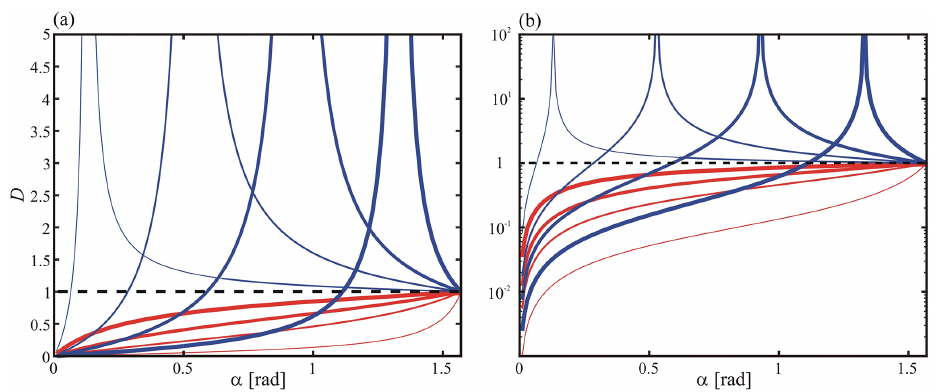
/λ Z , as a function of α , leaving a parametric dependence with ψ (see text). Arbitrary Figure 2. (a) Examples of the distortion in D = λ ap Z constant and progressive ψ values within the interval [ 0 ,π ] rad are shown. Underestimation of λ Z occurs when (D < 1 )ψ = 0 . 1, 0.5, 0.9, 1.3rad (curves with increasing thickness, from thin red to thickest red). Overestimation of λ Z occurs when D > 1 and ψ = 1 . 7, 2.1, 2.5 and 2.9rad (thin blue to thickest blue curves). Note that the upper blue branches for ψ > π/ 2 diverge at singular values. This is better appreciated in (b) . The horizontal dashed line corresponds to the “non distortion” case. Considerable general departures from this non distortion limit ( D = 1) are seen. (b) The same content as in (a) , here in linear-log axes.